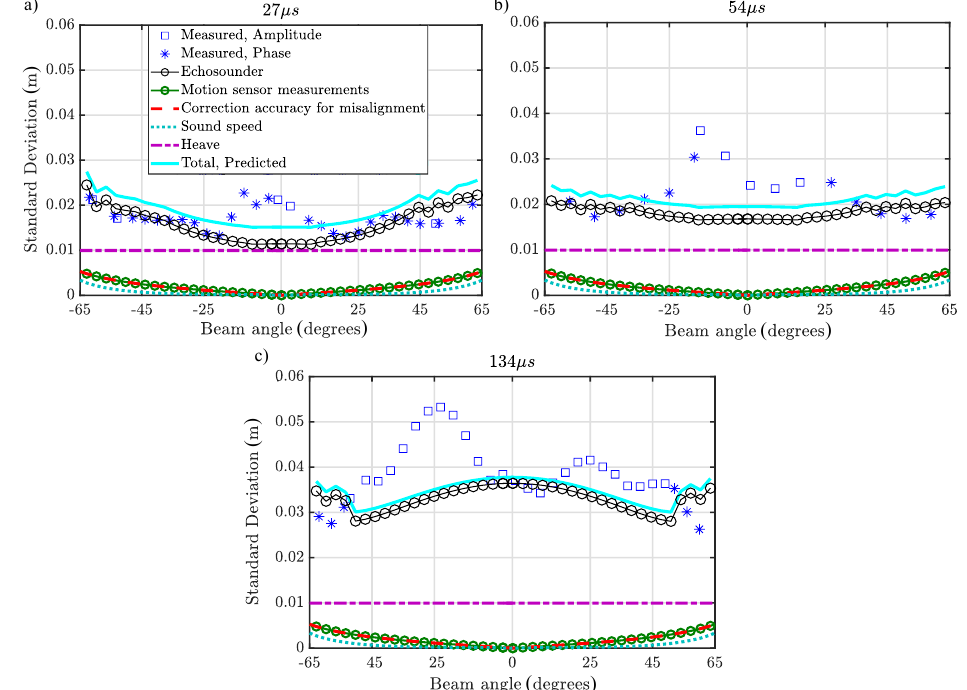
Figure 5. Bathymetric uncertainty derived from the measurements (blue markers) and those predicted for a water depth of 10m and a pulse length of ( a ) 27µs, ( b ) 54µs, and ( c ) 134µs. The change from amplitude to phase detection is shown by switching from square markers to asterisks with the same color. The location of this switch was similarly applied in the